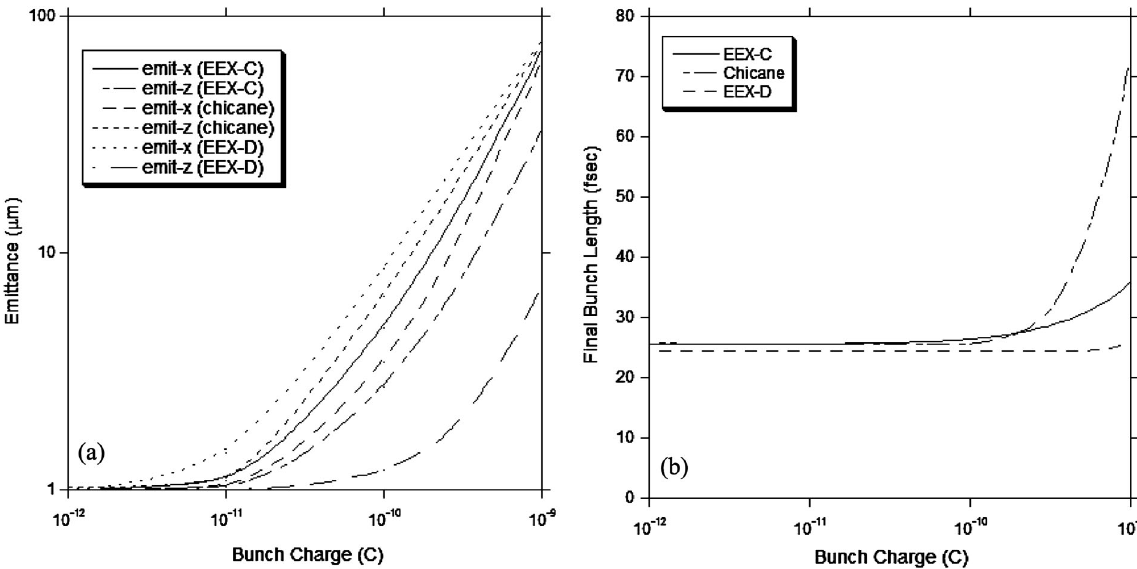
FIG. 5. (a) Horizontal and longitudinal emittance comparison between a chicane and an EEX. Emittance growths are comparable. (b) Increase in final bunch length resulting from CSR, for a chicane and an